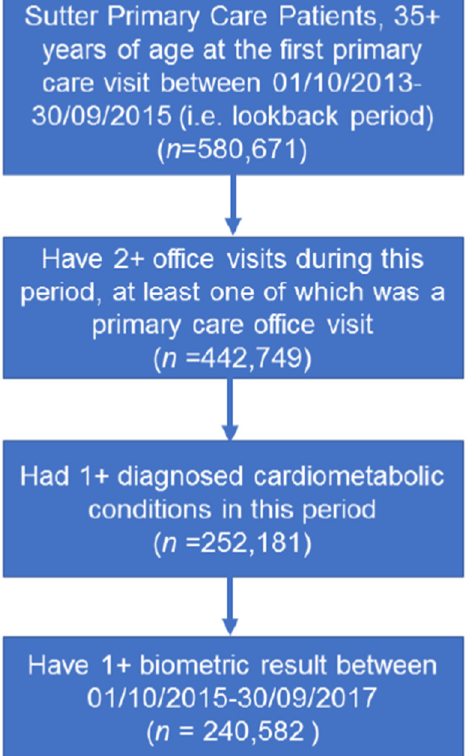
Figure 2. Flowchart for study cohort identification. Flowchart for inclusion of Sutter primary care patients 35+ years of age to identify individuals with a cardiometabolic diagnosis and related health gap.